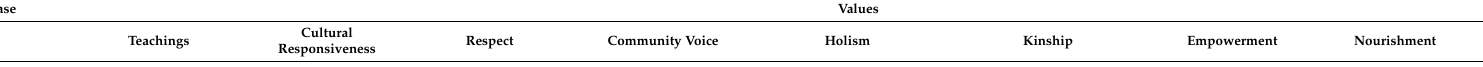
Table A1. Data from consensus